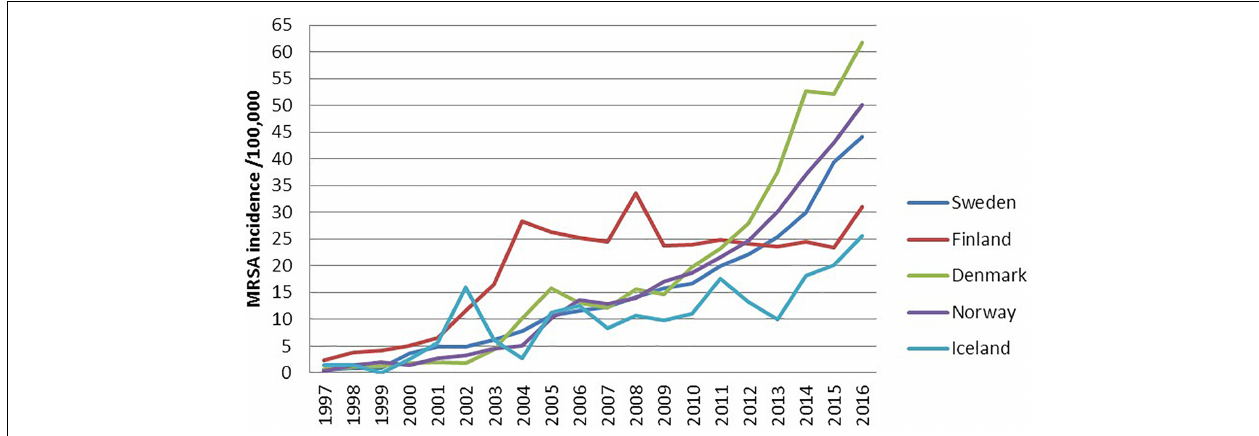
FIGURE 1 | Incidence of notified MRSA cases in the Nordic countries, 1997–2016.